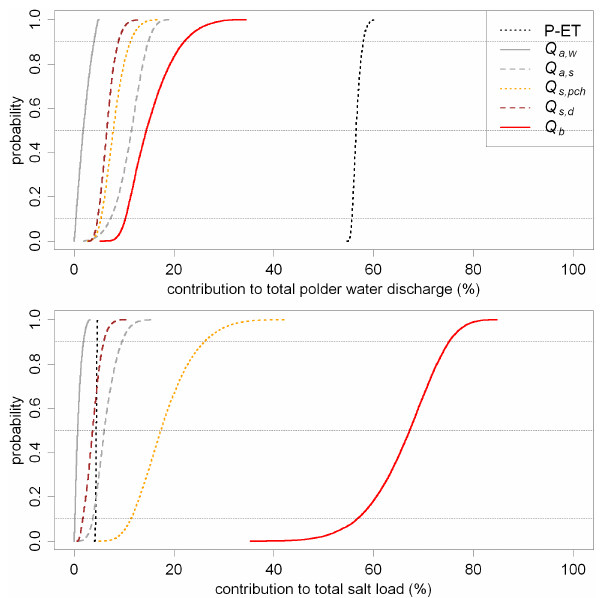
Fig. 4. Cumulative probability distribution function for the contri- bution of different sources to the total polder water discharge and total salt load of the polder (in %) (GLUE analysis